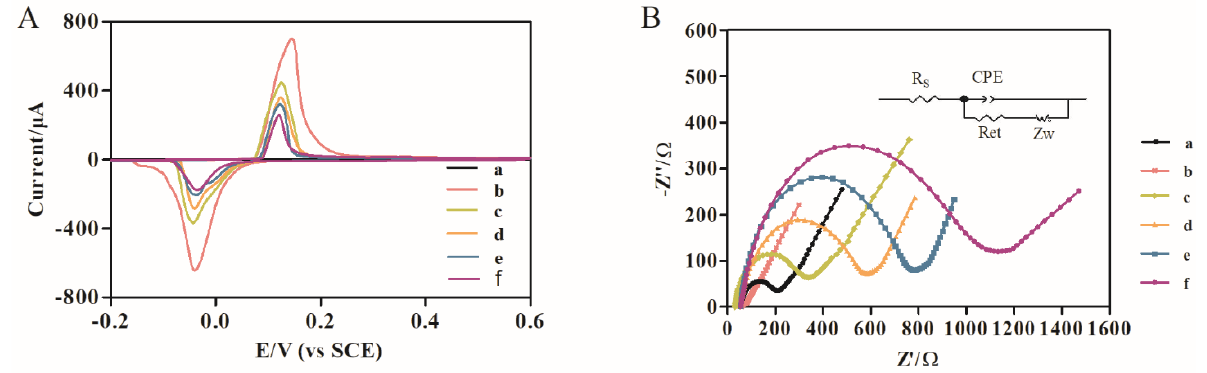
Figure 4. CVs ( A ) and EIS ( B ) of the same electrode at different stages. a. bare gold electrode, b. rGO- PEI-Ag-Nf, c. SPA/rGO-PEI-Ag-Nf, d. anti-ASA/SPA/rGO-PEI-Ag-Nf, e. BSA/anti-ASA/SPA/rGO- b. rGO-PEI-Ag-Nf, c. SPA/rGO-PEI-Ag-Nf, d. anti-ASA/SPA/rGO-PEI-Ag-Nf, e. BSA/anti- PEI-Ag-Nf, f. ASA/BSA/anti- ASA/SPA/rGO-PEI-Ag-Nf. ASA/SPA/rGO-PEI-Ag-Nf, f. ASA/BSA/anti-